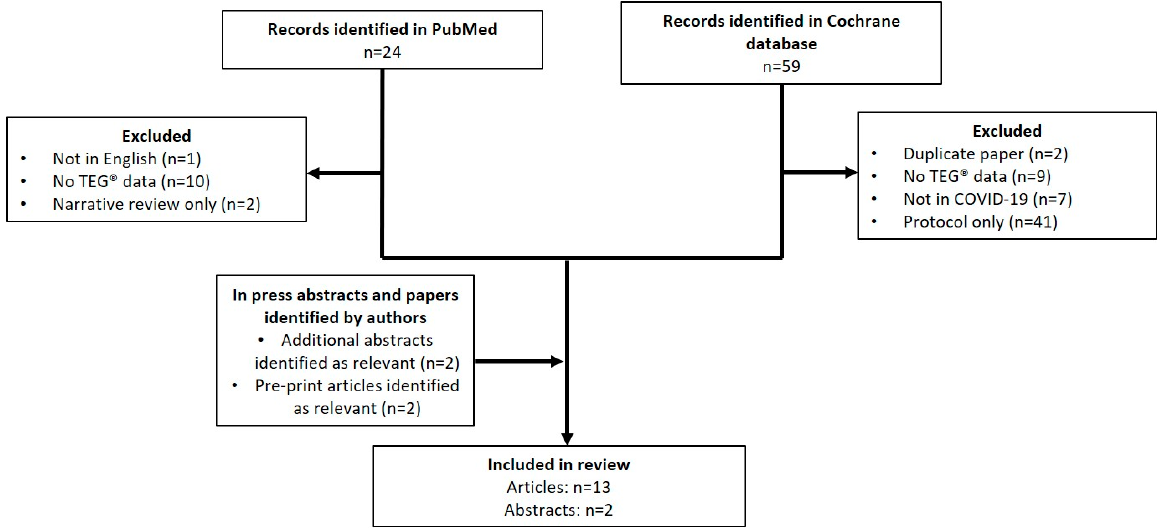
Figure 1. PRISMA diagram showing articles identified for inclusion in the review. COVID-19, coronavirus disease 2019; PRISMA, Preferred Reporting Items for Systematic Reviews and Meta-Analyses; TEG®, thromboelastography.